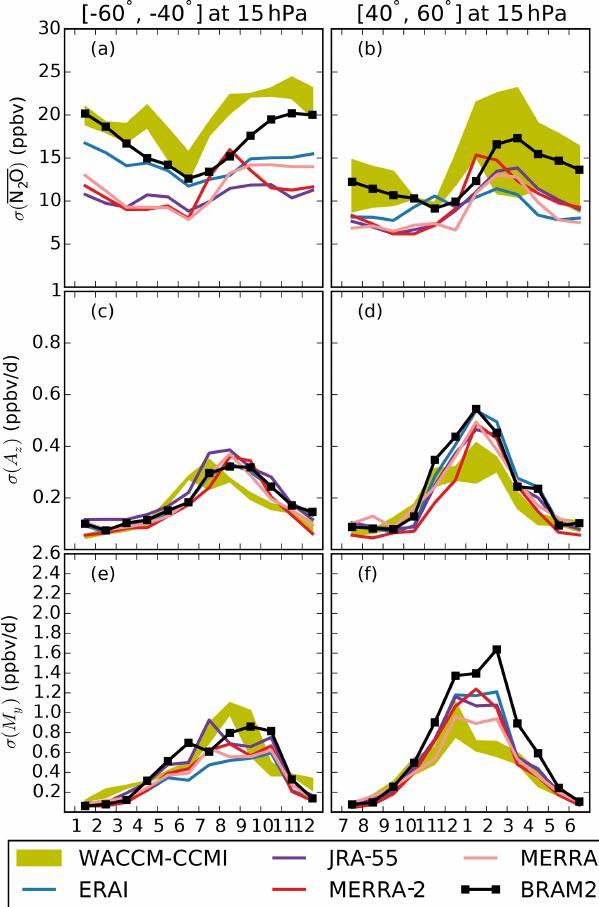
Figure 11. As for Fig. 10 but for the middle latitudes: (a, c, e) south- ern midlatitudes (40–60 ◦ S); (b, d, f) northern midlatitudes (40– 60 ◦